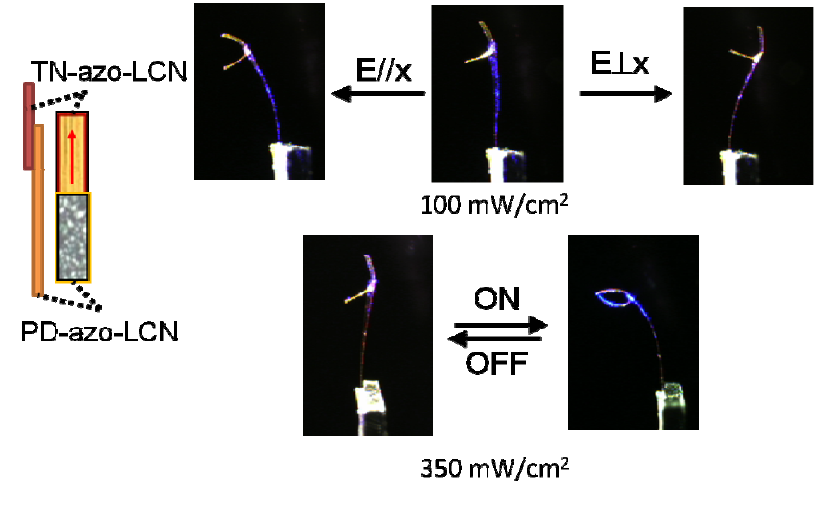
Figure 5. Photomechanical response of a TN-azo-LCN/PD-azo-LCN composite structure. When the PD-azo-LCN base is irradiation with 100 mW/cm 2 , optically fixable forward/reverse bending is observed. Addressing the TN-azo-LCN portion of the structure opens and closes the “mouth” of structure. See MOVIE1 in Support